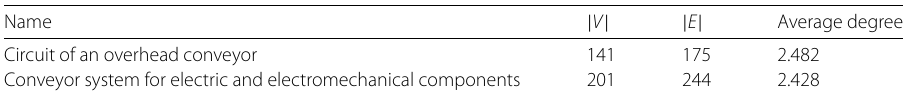
Table 2 Table of real-world data